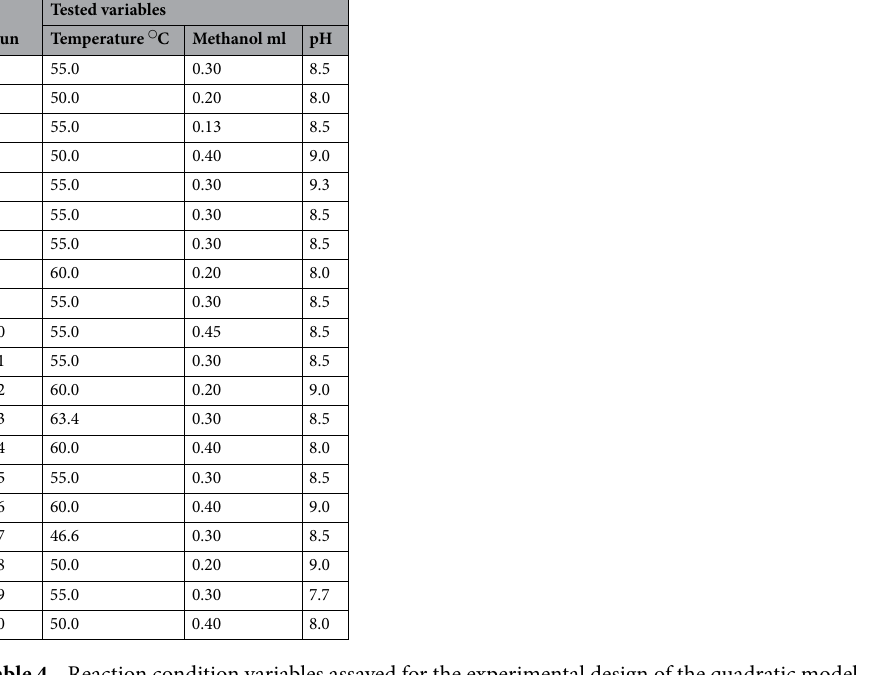
Sum of squares Degrees of freedom Mean square F-value